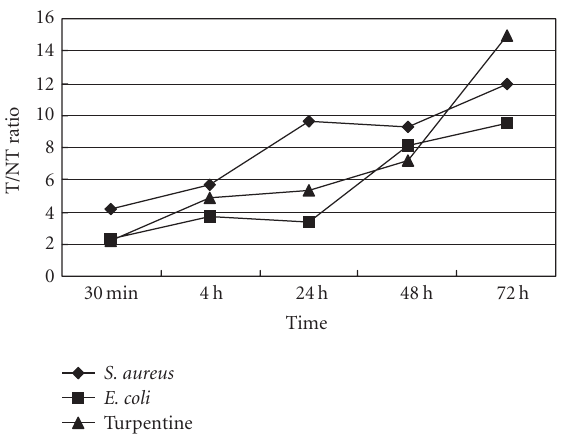
Figure 3: Change of T/NT in the S. aureus , E. coli , and turpentine oil group.